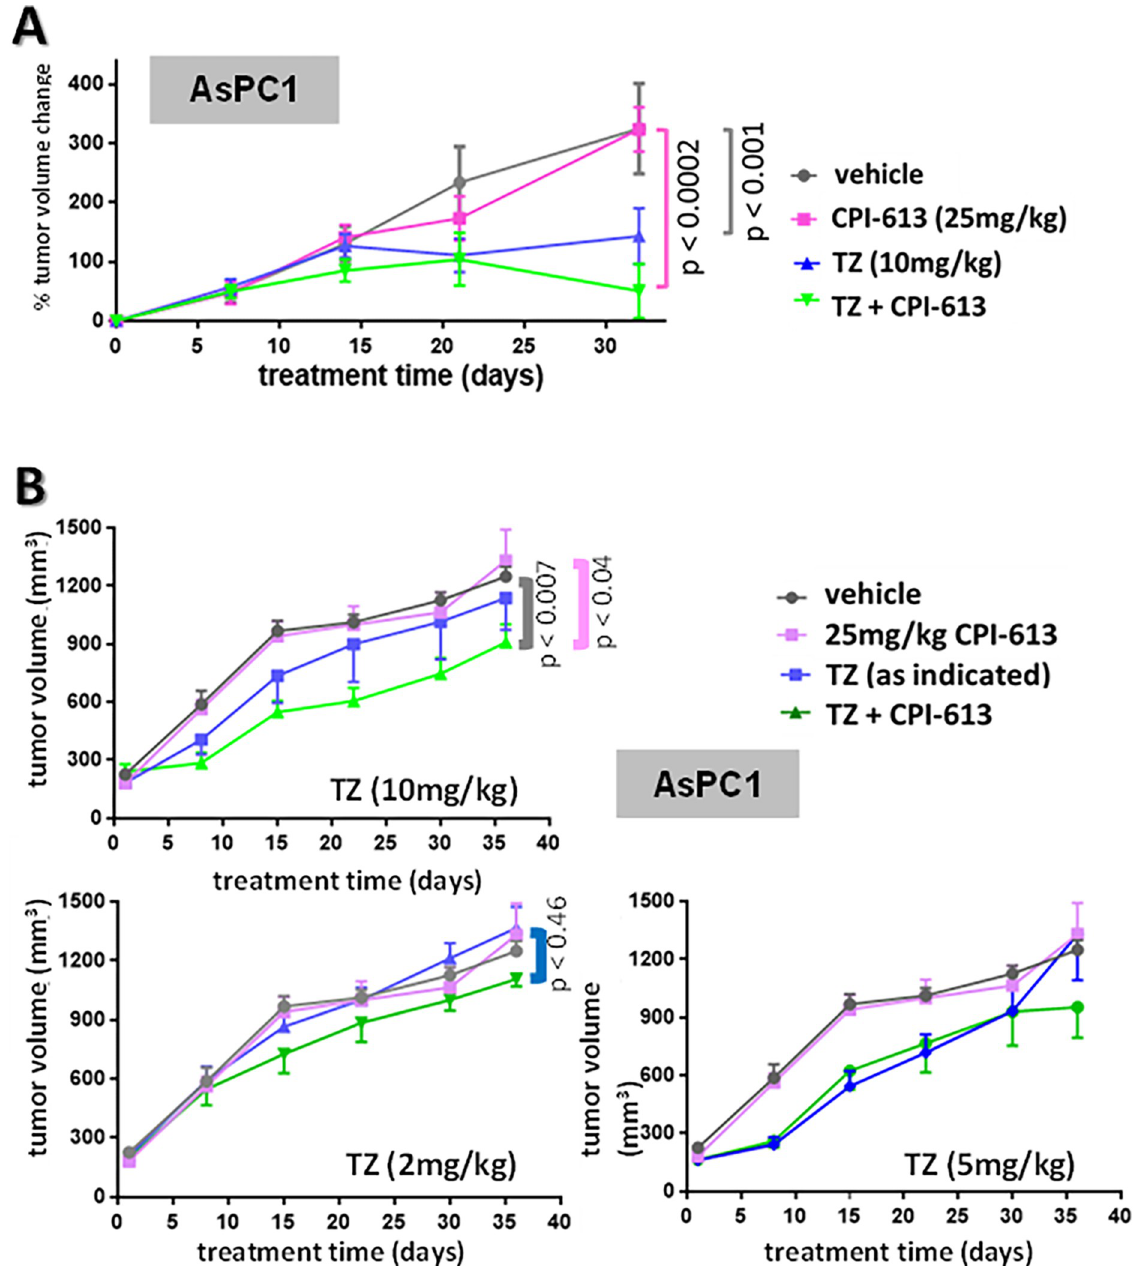
Fig 6. In vivo TZ sensitization of resistant AsPC1 xenograft to CPI-613. A. Pilot study of TZ and CPI-613 effects on TGI in AsPC1 xenografts . AsPC1 cells were inoculated subcutaneously on the flank and drug combinations indicated were administered IP three times a week (MWF) (Materials and Methods). Each arm contained 10 animals. In this initial experiment the variation in starting tumor size was greater than in the other TGI experiments in this study; thus, we plot the data here normalized to tumor starting size. AsPC1 tumor sensitivity to TZ varies noticeably between this experiment and the study in panel B; the reasons for this variation are currently unknown. B. Dose ranging of TZ sensitization to CPI-613 TGI of AsPC1 xenograft . Shown is a study assessing TZ and/or CPI-613 effects on AsPC1 xenograft tumor growth in vivo . AsPC1 cells were inoculated subcutaneously on the flank and drug combinations indicated were administered IP three times a week (MWF) (Materials and Methods). All arms had 10 animals, except for the vehicle arm of 9. Note that these data and those in Fig 7D are from the same large TGI study; thus, the vehicle and CPI-613 control data are replicated in both figures. Note that the panel B samples are all from the same large TGI study and, thus, the mock and CPI-613 treatment data are replicated in all three panels.